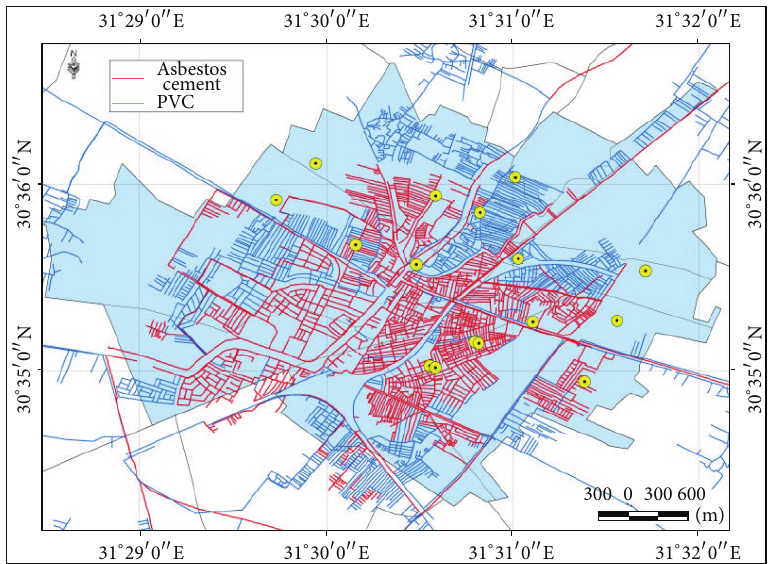
Figure 4: The positive E . coli isolates in relation to Zagazig water network with its different materials of construction.